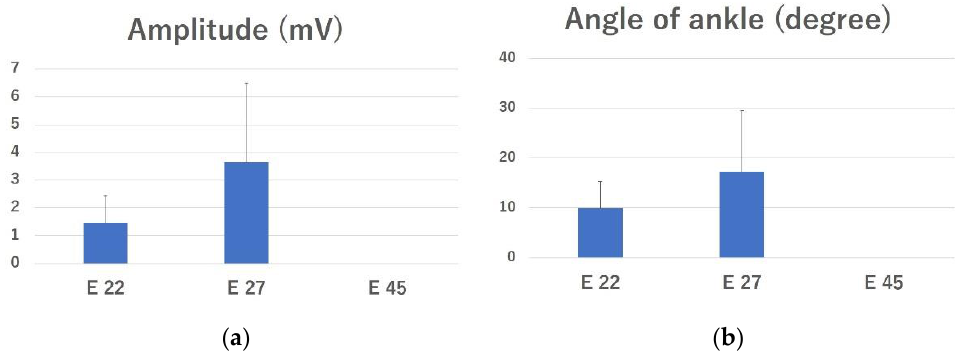
Figure 2. Electrophysiological evaluation. ( a ) Amplitude of compound muscle action potentials (CMAPs) recorded in the tibialis anterior muscle. ( b ) Angle of the ankle was calculated before and after electrical stimulation. The data are presented as mean ± SE.